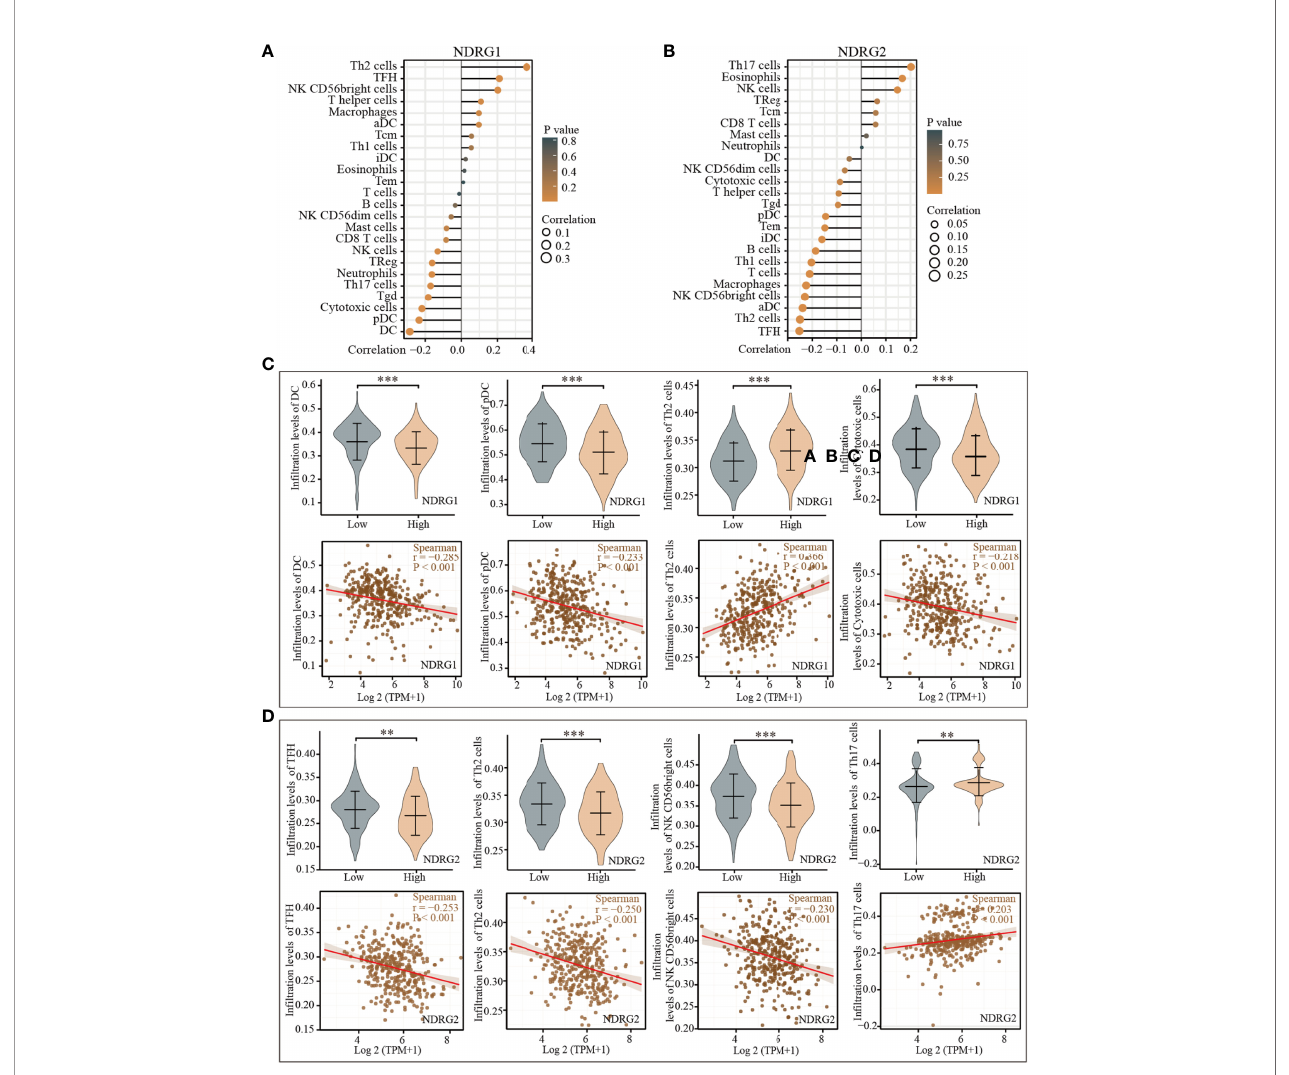
FIGURE 5 | Correlation of the expression of NDRG1 or NDRG2 with immune in fi ltration. (A, B) The forest plots showed the correlations of NDRG1 or NDRG2 expression with immune in fi ltration in 24 types of immune cells. The size of the dots shows the absolute values of Spearman ’ s correlation coef fi cient. (C, D) Violin plots and scatter plots showing the difference and relevance of representative immune cells in fi ltration level. ** P < 0.01; *** P <